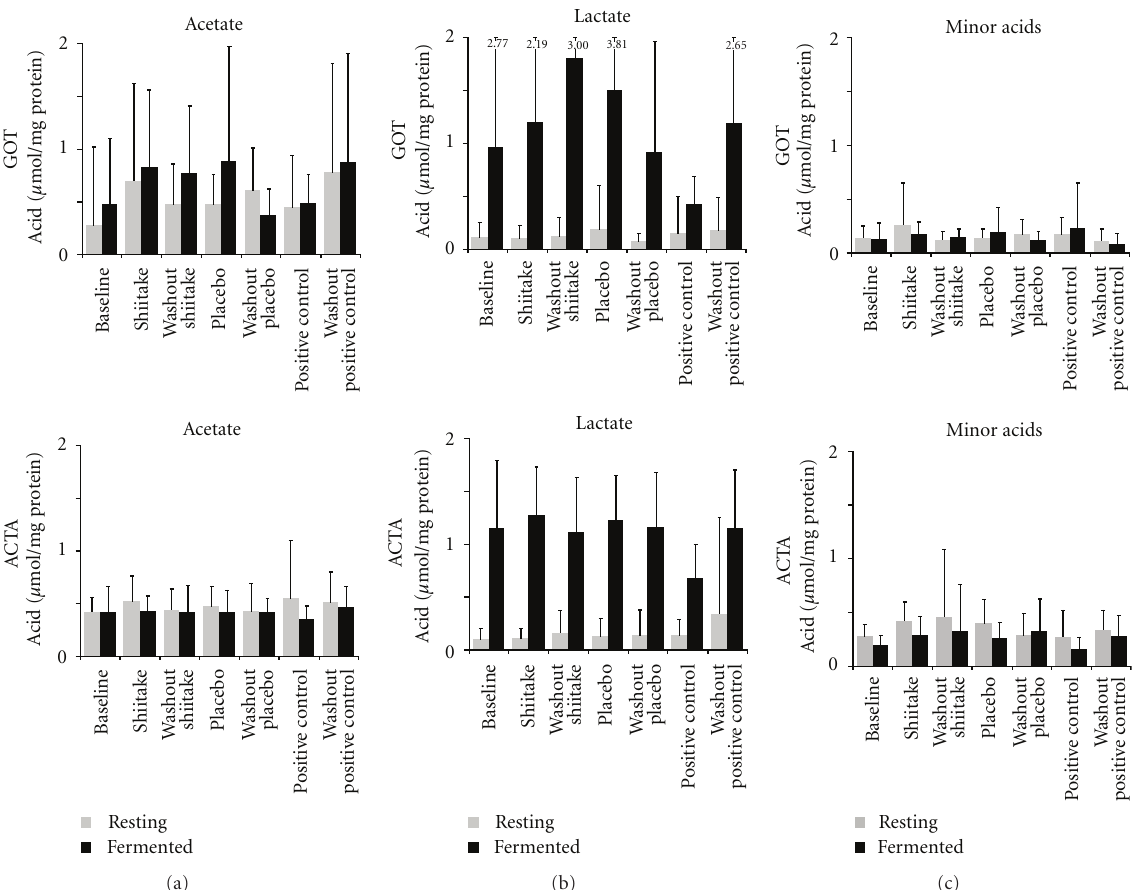
Figure 2: Amount of acetate, lactate, and minor acids (propionate, formate, succinate, and butyrate) in resting (presucrose) and fermented (postsucrose) dental plaque. After baseline, after the three legs of crossover (shiitake, placebo, positive control [AmF-SnF 2 ]) and after three washout periods (washout shiitake, washout placebo, and washout positive control) are all shown. Data are shown separately for volunteers in Gothenburg (GOT) and Amsterdam (ACTA). Mean values ± SD for 30 (GOT) and 35 (ACTA) subjects, respectively. Due to the high standard deviation when analysing lactate in fermented plaque for five of the test sessions in GOT, the y -axis does not correspond to the actual figure. The total amount (mean ± SD) is given above each individual column.